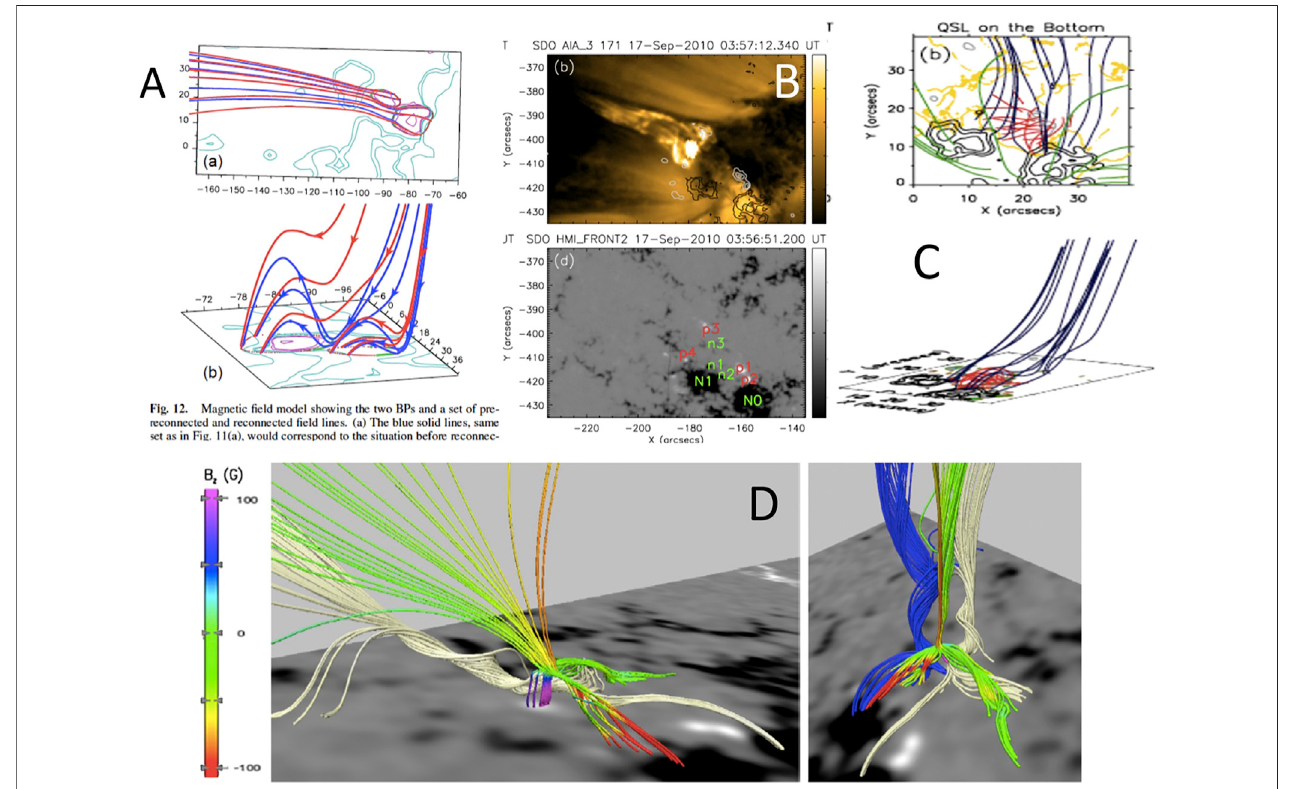
FIGURE4| Magneticreconnectioninitiatingsolarjetsinbaldpatch(BP)andinnullpoint. (A) Reconnectionbybaldpatches,viewedfromaboveandsideview[from Chandra et al. (2017)]; (B) Jet observed by the AIA 171 Å fi lter and the corresponding HMI magnetic map; (C) NLFF extrapolated magnetic fi eld lines with bald patch region and electric currents [from Guo et al. (2013)]. (D) NLFF extrapolated magnetic fi eld showing bald patch and null point [from Schmieder et al.